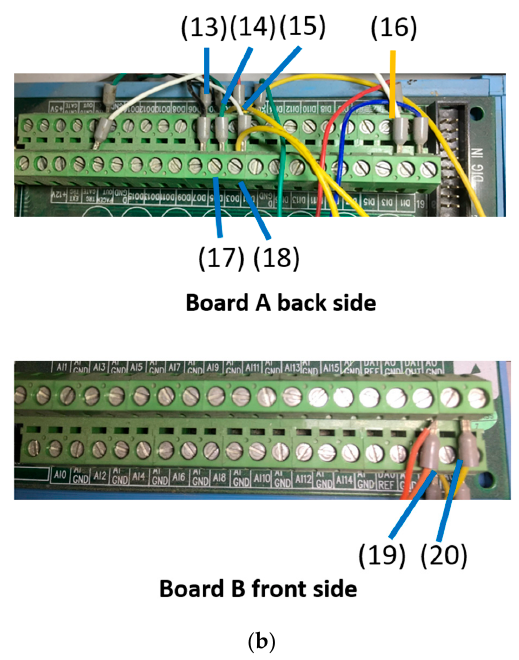
Figure 9. I/O communication interface for ( a ) Board A; ( b ) Board B .